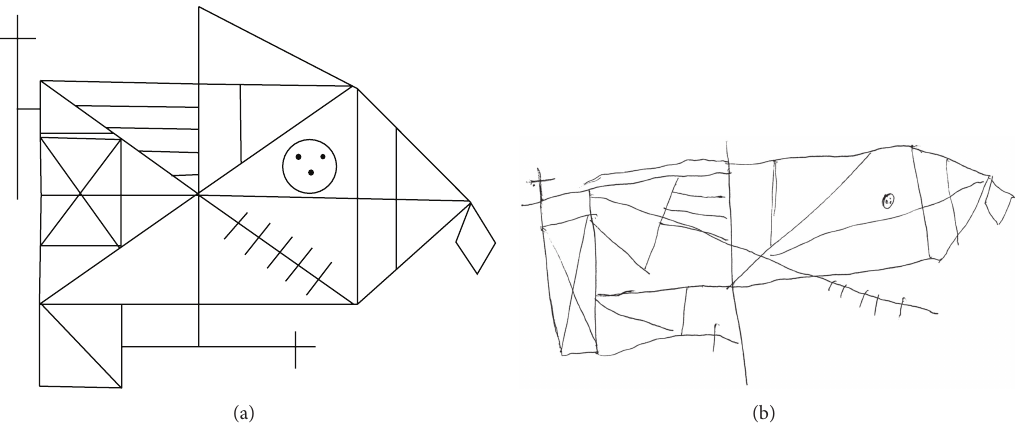
Figure 2: BG’s copy of the Rey-Osterrieth complex